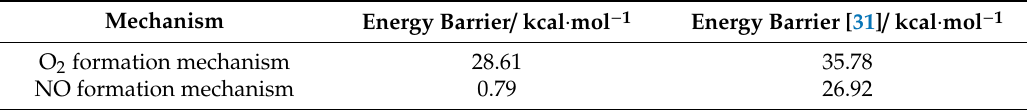
Table 2. Energy barrier comparison of the second N 2 O molecule decomposition